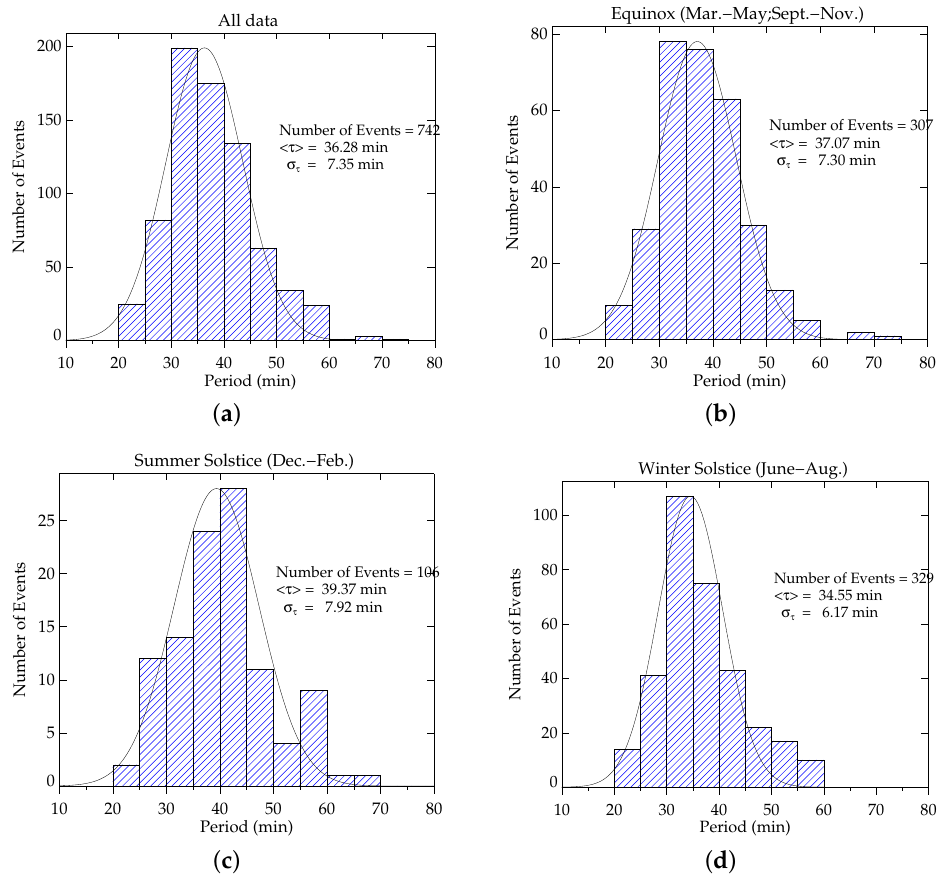
Figure 8. Distribution of the observed period of the MSTIDs observed between January 2014 and December 2019 for ( a ) all seasons, ( b ) equinoxes, ( c ) summer, and ( d )